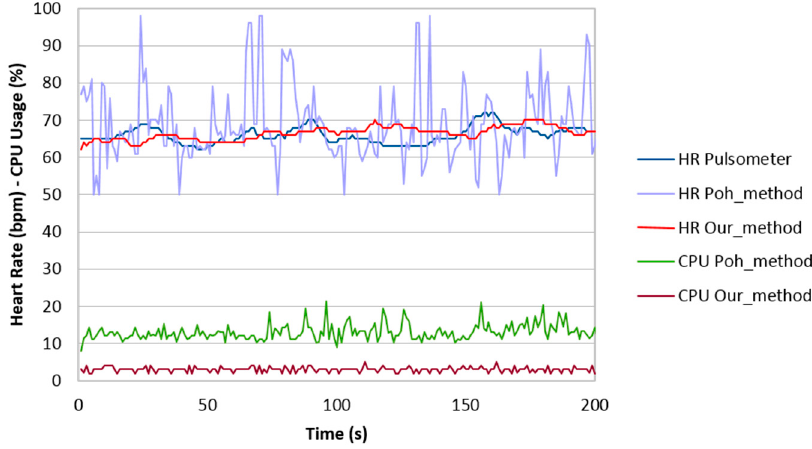
Figure 8. Performance comparison between our method and ICA.